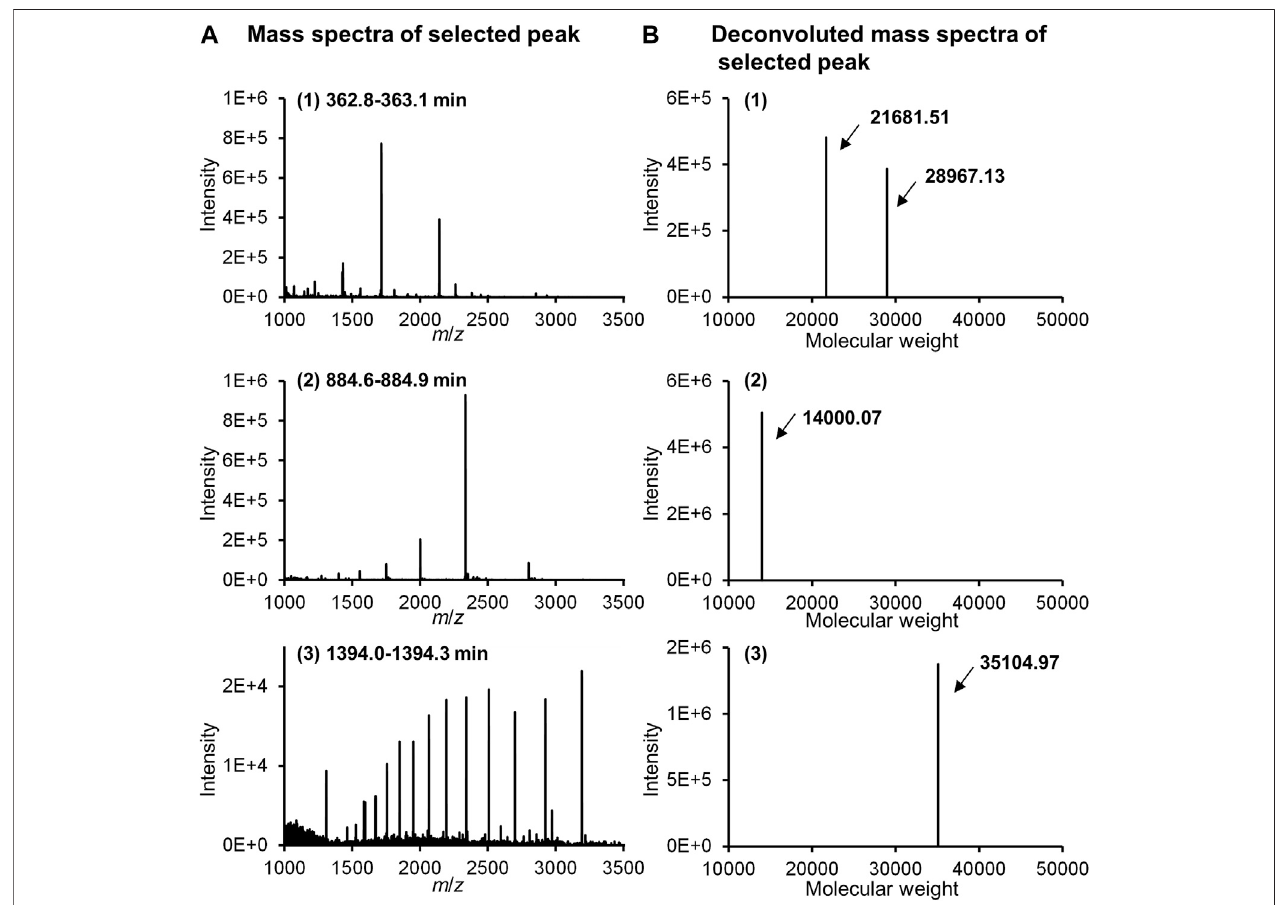
FIGURE 11 | MS spectra (A) and deconvoluted MS spectra (B) of selected peaks in Figure 10B .